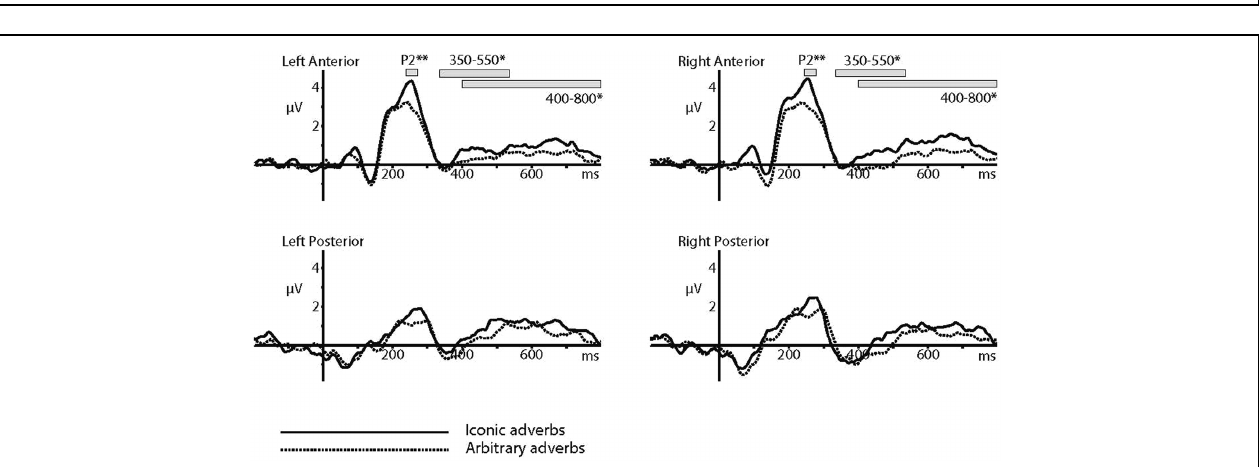
FIGURE 2 | Event-related potentials and topoplots in response to iconic and arbitrary adverbs.